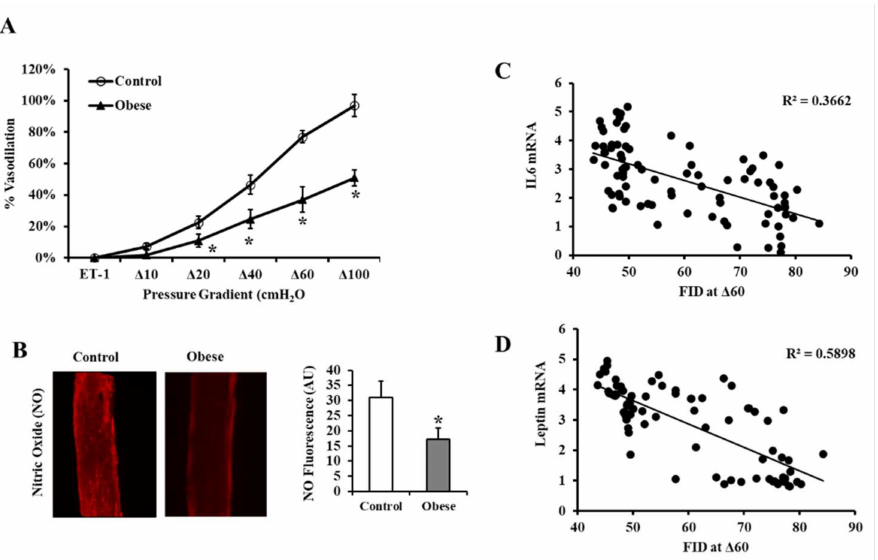
Figure 6. FID measurements in VAT-isolated resistance arterioles. ( A ) FID measurements correspond to increasing intraluminal pressure gradients of 10–100 cmH 2 O in VAT arterioles obtained from obese ( n = 60) and non-obese ( n = 60) subjects. ( B ) Representative images by fluorescence microscopy of NO generation in VAT-isolated arterioles ( n = 60, each). ( C ) Charts represent NO fluorescent signals measured and expressed in arbitrary units using NIH Image J software. ( D ) Scatter plots and Spearman correlation coefficient (r) of leptin and IL6 mRNA levels and arteriolar FID. Results are shown as means ± standard error (SE), and the * symbol reflects a p -value < 0.05 when comparing obese subjects with